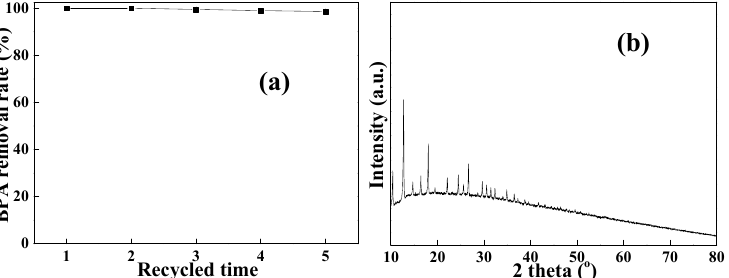
Figure 6. ( a ) Recyclability of ZFP ([BPA] 0 = 0.02 mM, flow rate = 5 mL/min), ( b ) XRD pattern of recycled ZFP.